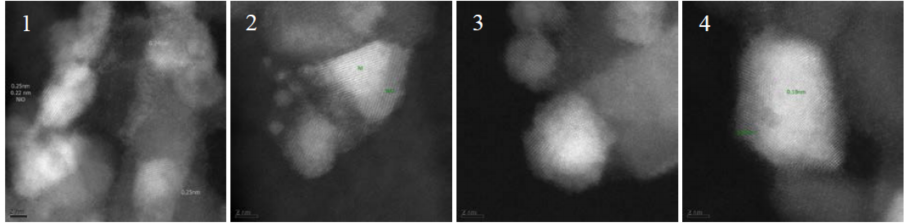
Figure 9. TEM images of fresh and spent catalyst after >250 h TOS in run H. Catalyst before reaction: ( 1 ) catalyst as delivered, partly reoxidized; and ( 2 ) after in situ reduction. Catalyst after reaction: Molecules 2017 , 22 , 134 ( 3 ) the top most bed; and ( 4 ) second catalyst bed.